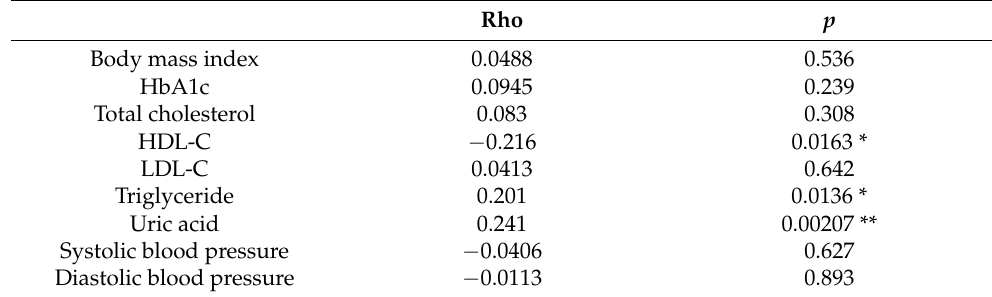
Table 2. Correlations of PASI with indicators of cardiometabolic diseases before treatment with